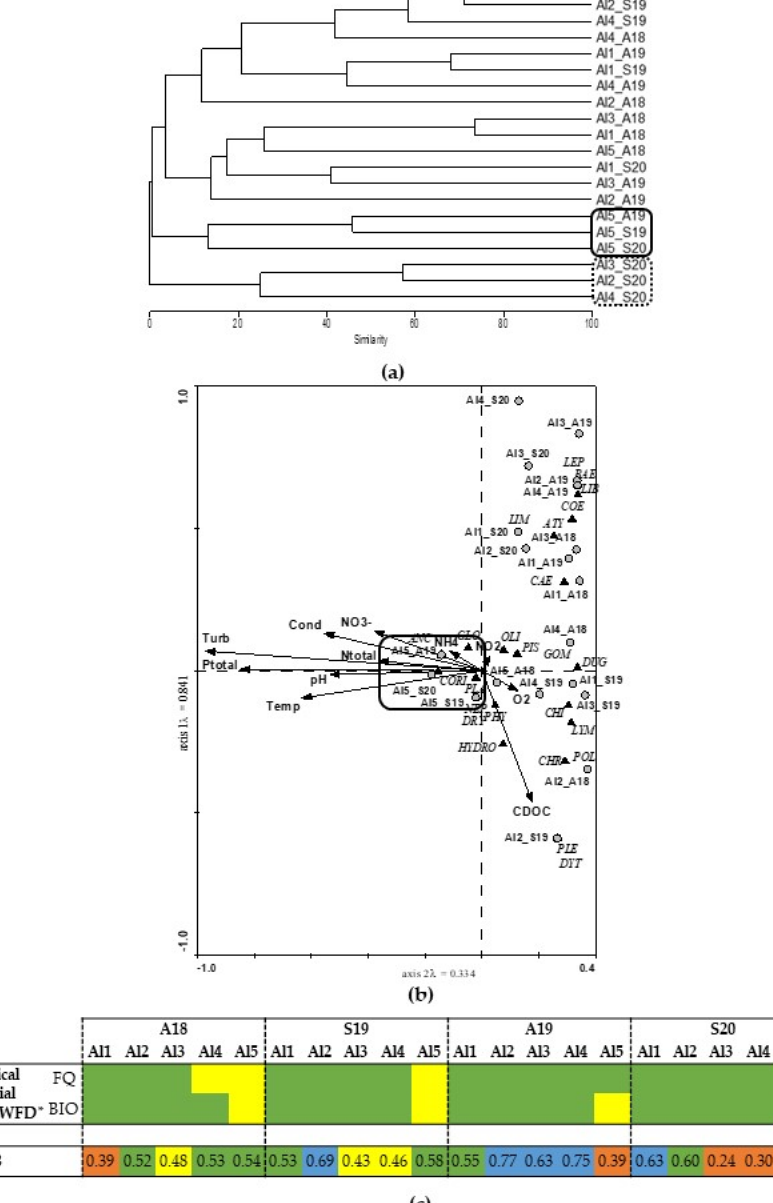
Figure 4. ( a ) Alqueva complete linkage dendrogram of benthic macroinvertebrates similarity; ( b ) Canonical Correspondence Analysis (CCA); ( c ) ecological potential according to WFD parameters (see Table 1 for more information) and macrozoobenthos index for dam reservoirs (MZB) of the distribution of aquatic invertebrates (see taxa abbreviation in Table 2) through the sampling sites, periods, and environmental variables.